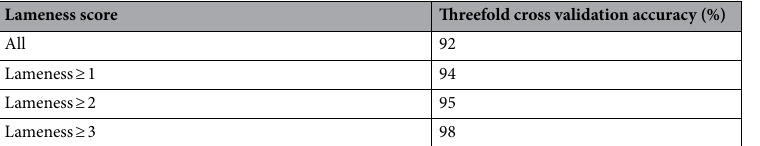
Table 14. Catboost threefold cross validation accuracy for scorer 2 for each of the 3 lameness score groups: separate degrees of lameness, scores 0 as non-lame with scores 1, 2 and 3 as lame, scores 0 and 1 as non-lame with scores of 2 and 3 as lame, scores 0, 1 and 2 as non-lame and a score of 3 as lame.